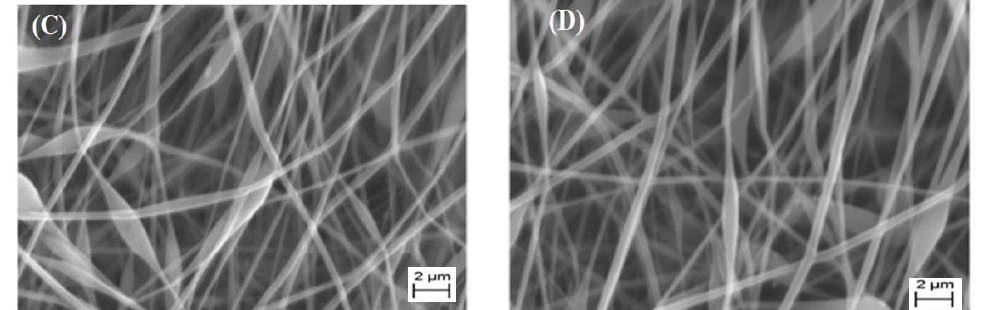
Figure 2. SEM images of electrospun CH/PVP nanofibers loaded with 10% 3β -cloro- 5α -cholestano- 2′ -methyl-2-oxazoline ( A ), 3β -acetoxy- 5α cholestano - 2′ -methyl-2-oxazoline ( B ), 3β -chloro-N-amido- 5α -cholestano-aziridine ( C ) and 3β -acetoxy- N-amido- 5α -cholestano-aziridine ( D ).